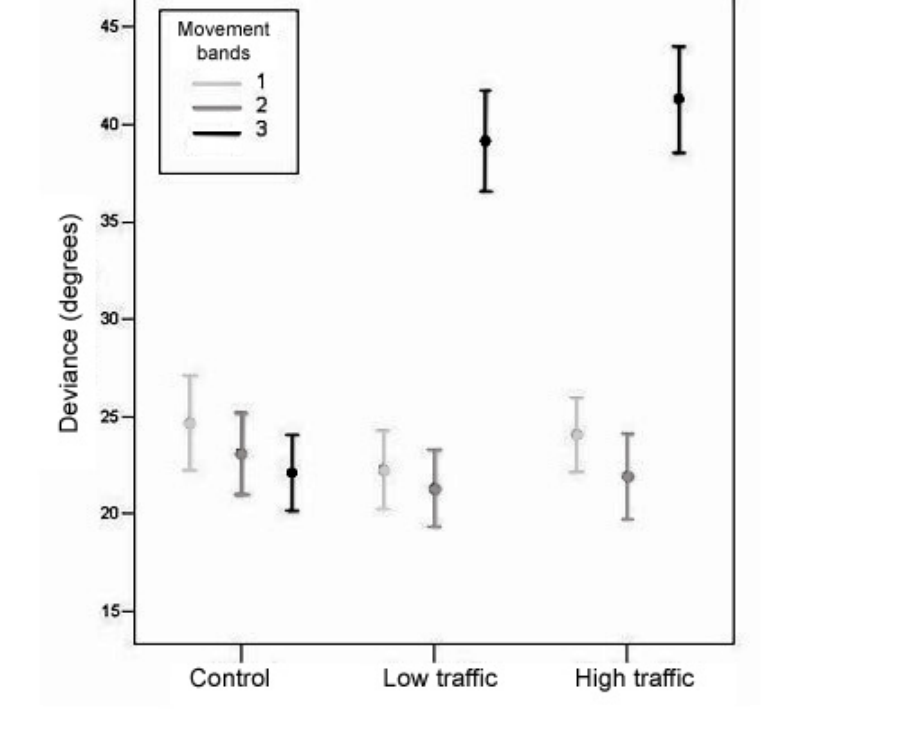
Fig. 3. Angular deviation of movement direction. Frogs tend to deviate from movement directly toward the road within 3.3 m of the road surface. Movement bands 1, 2, and 3 at low- and high-traffic sites correspond to 10.0–6.7 m, 6.6–3.4 m, and 3.3–0.0 m from the road surface, respectively. At control sites, movement bands 1, 2, and 3 correspond to 10.0–6.7 m, 6.6–3.4 m, and 3.3–0.0 m from the end of the 10-m monitoring area (see Fig.